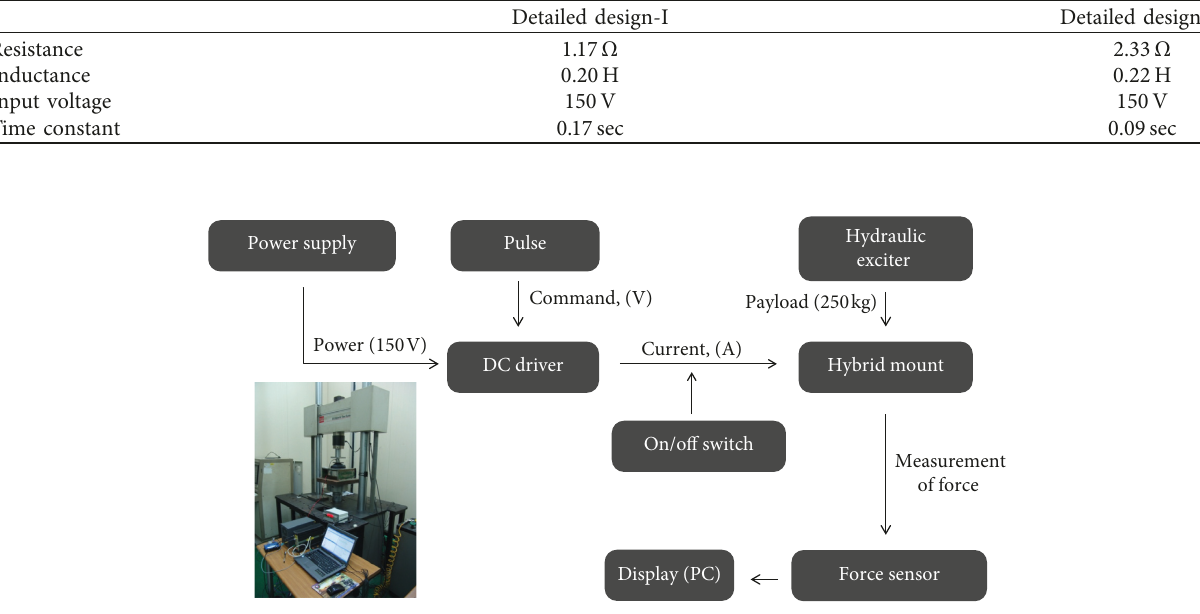
Figure 6: Configuration of blocking force measurements [2].